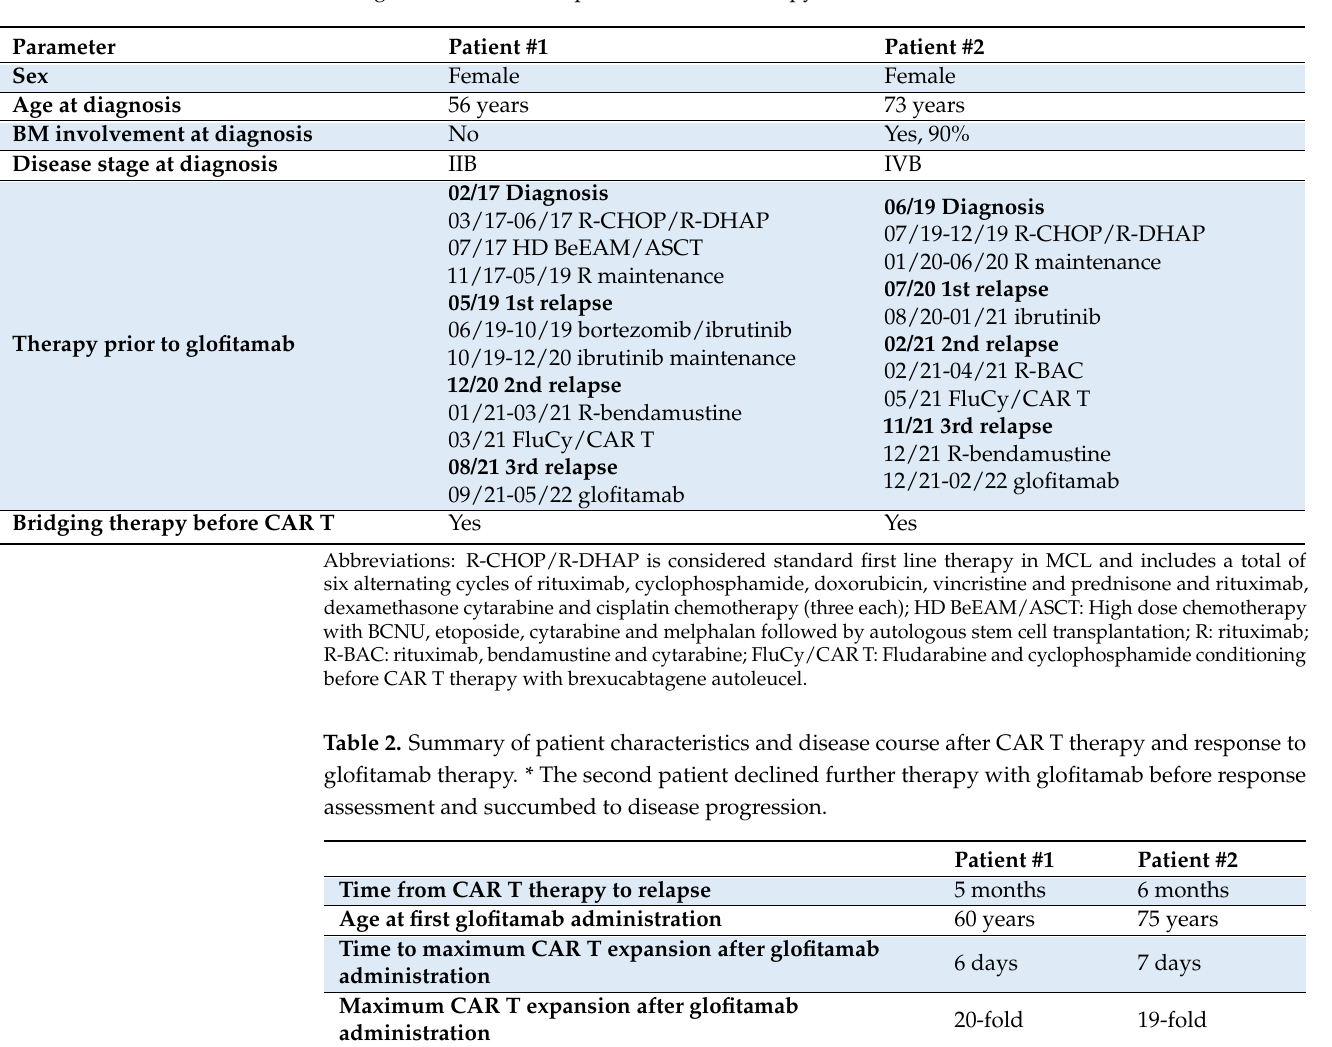
Table 1. Characteristics and time course of previous treatments of the two patients with MCL treated with glofitamab after relapse after CAR T therapy.